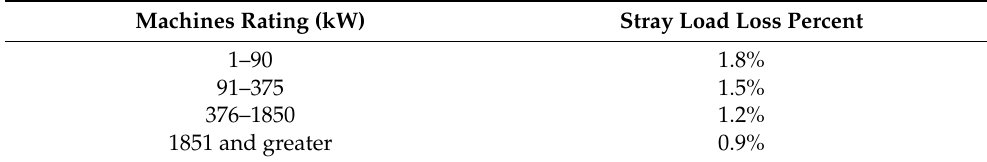
Table 1. Assumed values for stray load loss [8].